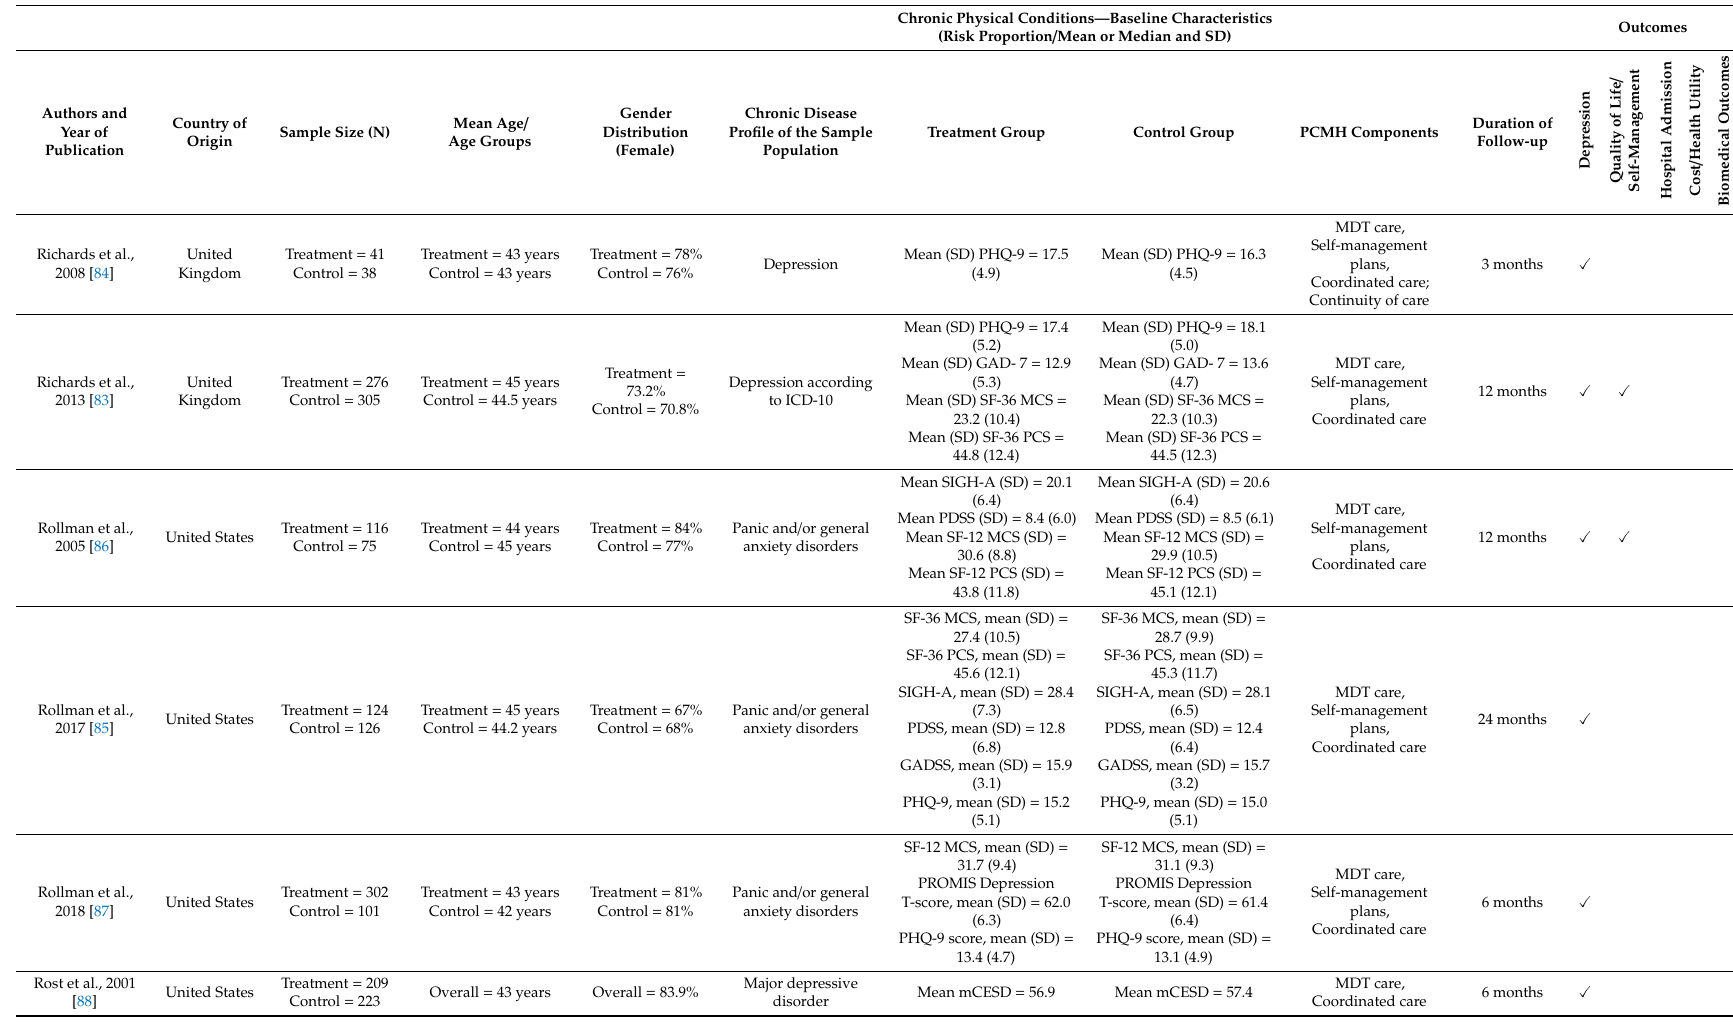
Table A3. Cont. Chronic Physical Conditions—Baseline Characteristics (Risk Proportion / Mean or Median and SD)